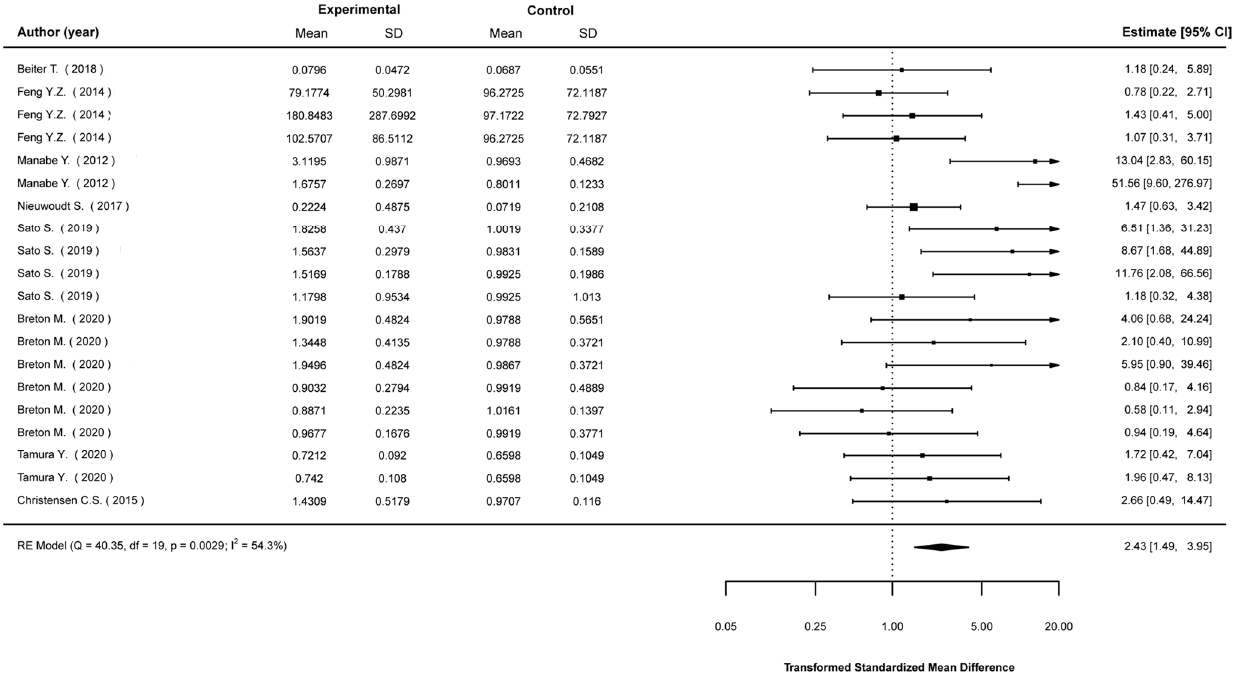
Figure 2. Findings of random-effects meta-analysis on the effects of EPS on Akt compared to non- stimulated cells. Results shown are transformed standardized mean differences and 95% confidence intervals, as an estimate of the log odds ratio. Differences greater than 1.00 favour the EPS cells compared to non-stimulated control cells